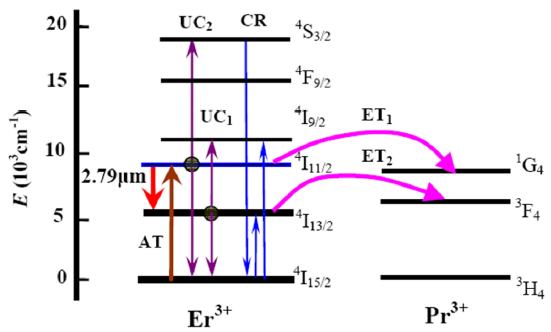
+ and Pr 3 + ions in Er,Pr:GYSGG